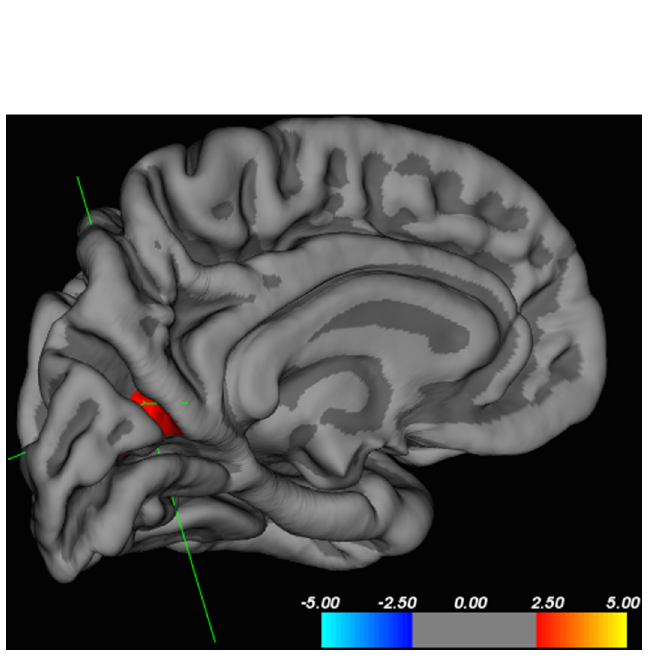
Fig 2. Whole-brain regression analyses within the patient group for correlation between cortical thickness and BD severity in QDEC (see Methods, Data Analyses and Discussion, ROI vs. Whole Brain Results for explanation of BD scores). Medial view of left hemisphere here shows positive correlation between BD scores and cortical thickness of the precuneus.